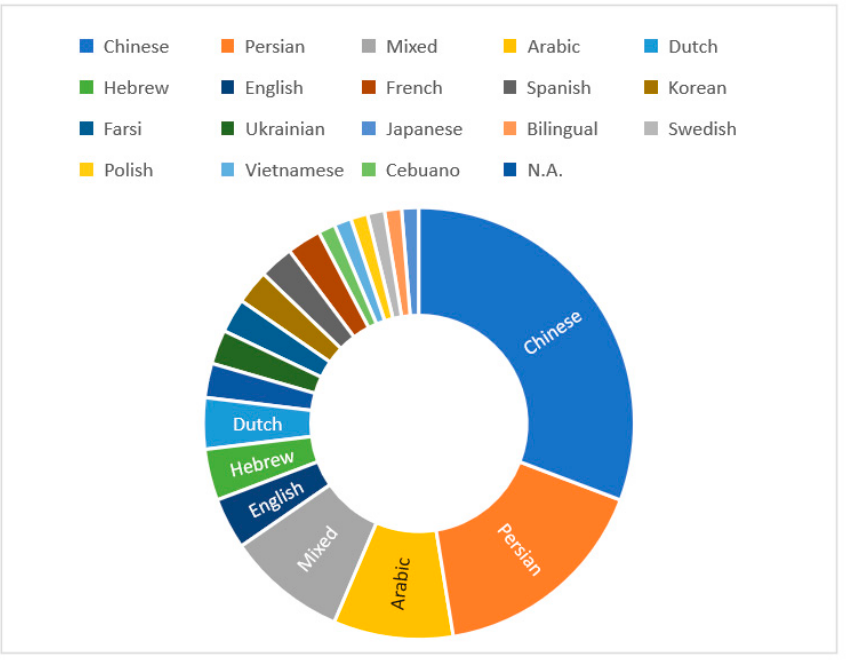
Figure 4. The L1 Backgrounds.